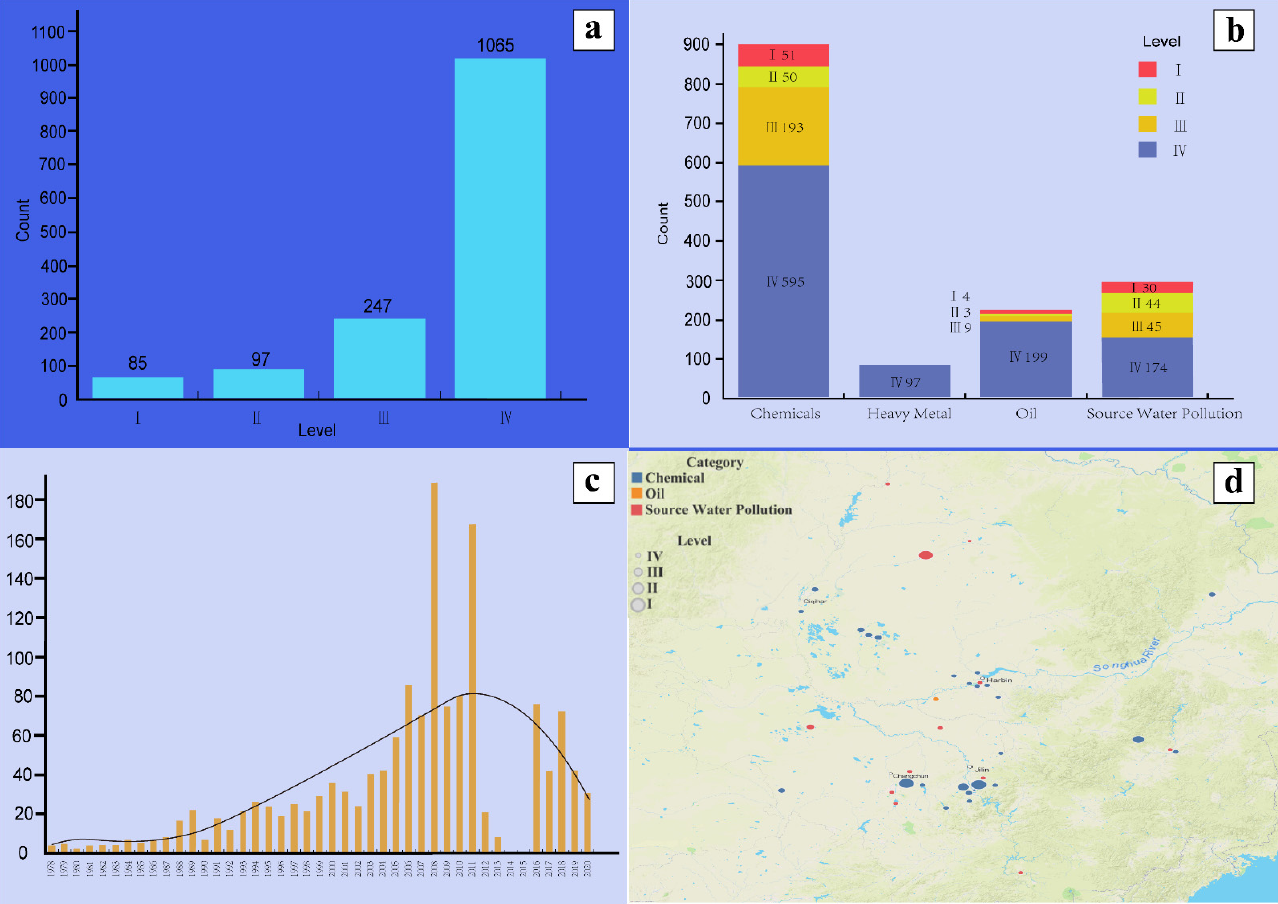
Figure 1. Water pollution accidents in China. ( a ) Source types, and the level of each type. ( b ) Spatial distribution of pollution accidents. ( c ) The number of accidents that happened each year and estimated trend. ( d ) The serious level of water pollution accidents.